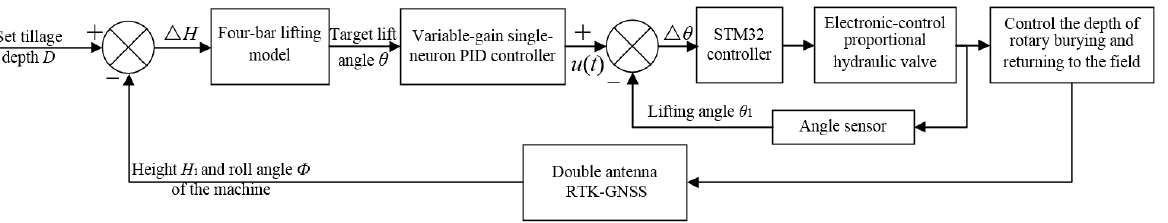
Figure 5. Overall structure of controller. Note: u ( t ) is the executed angle output by the variable-gain single-neuron PID controller, (°); θ 1 is the current steering angle measured by the angle sensor, (°); ∆ θ is the actual required angle, (°).